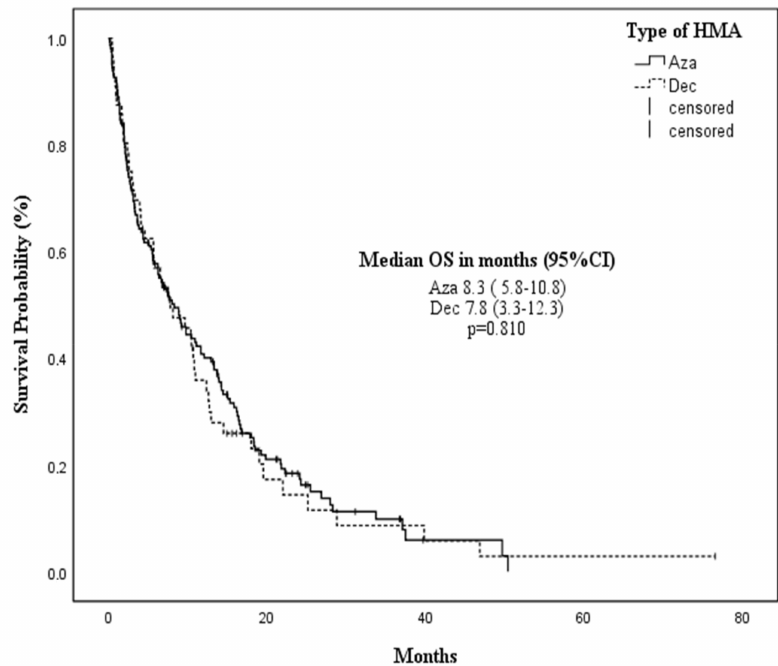
Figure 2. Median overall survival according to the hypomethylating agent.